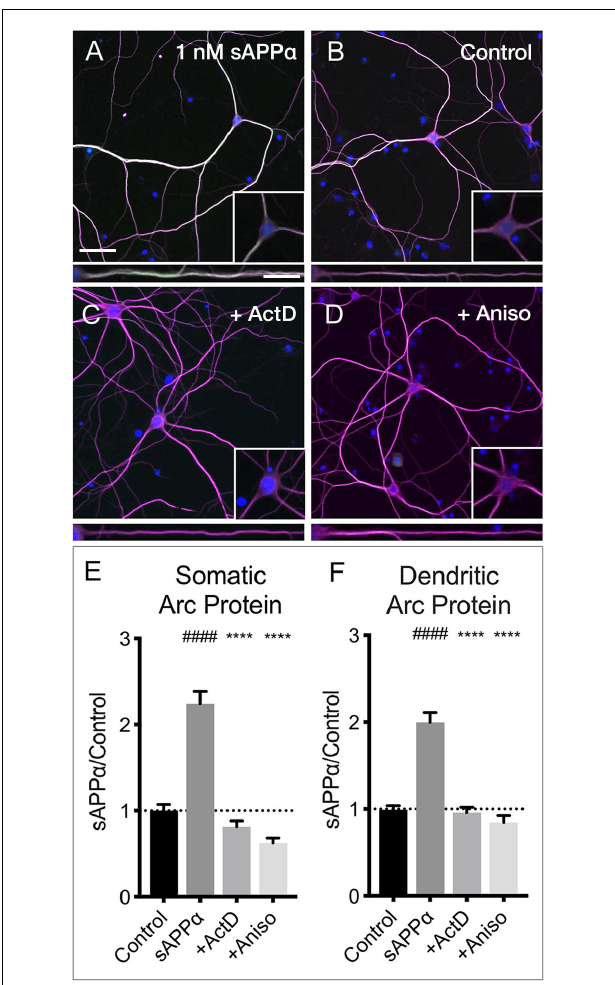
FIGURE 6 | Arc protein expression is prevented by inhibitors of transcription and translation. Representative images showing Arc protein levels in (A) sAPP α (1 nM, 2 h, n = 157) and (B) no drug control ( n = 115 cells) conditions. sAPP α -mediated Arc increase is inhibited with co-application of (C) Actinomycin-D ( n = 104) or (D) Anisomycin ( n = 30) in the (E) somata and (F) dendrites. Significance was calculated using a Kruskal–Wallis one-way ANOVA with Dunn’s multiple comparisons test. ∗∗∗∗ / #### p ≤ 0.0001. Representative images show neurons (magenta), Arc protein (green), nuclei (DAPI; blue) (scale bar = 50 µ m) and magnified somatic (inset, bottom right) and dendritic (100 µ m; lower panels; scale bar = 10 µ